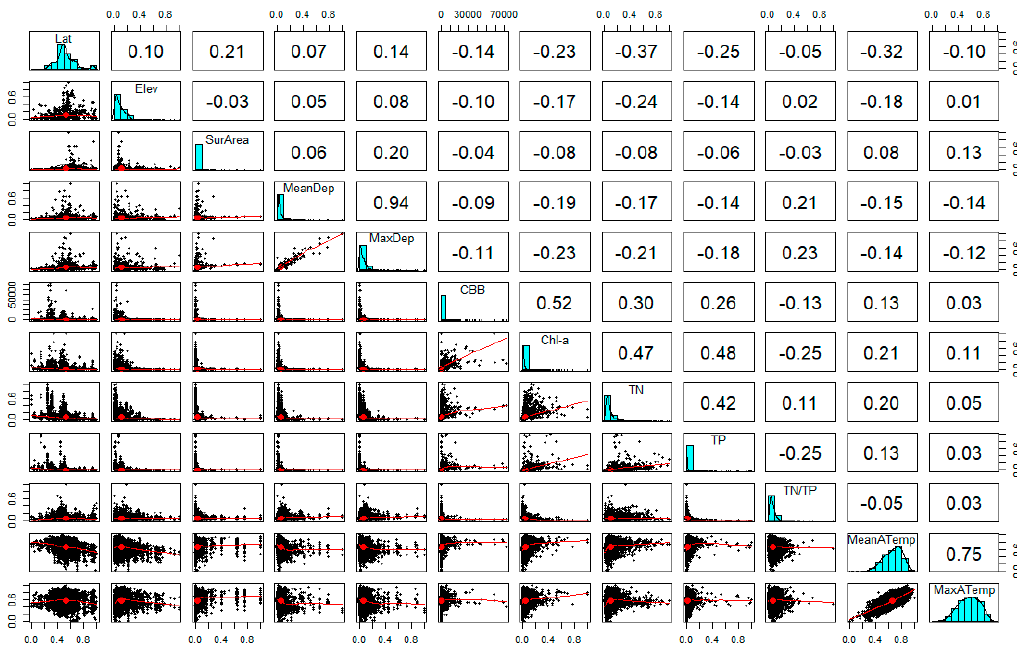
Figure 4. Correlation matrix of the response variable CBB against the candidate explanatory variables for the multiple linear regression and machine learning models. The upper right panel displays the correlation coefficient (r) of each variable pair, the lower left panel displays the scatter plot with a smoothed regression curve and on the diagonal the distribution of all the variables is illustrated.